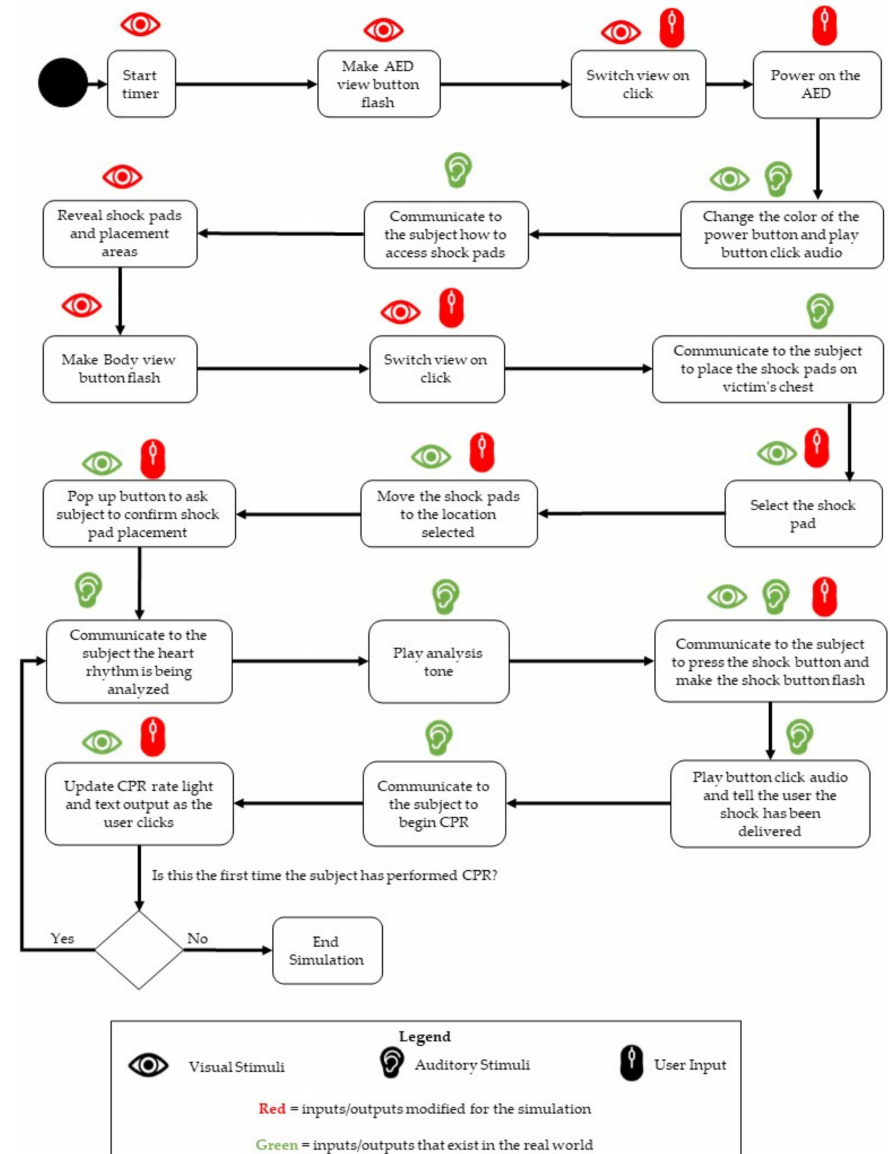
Figure 1. UML diagram of simulation